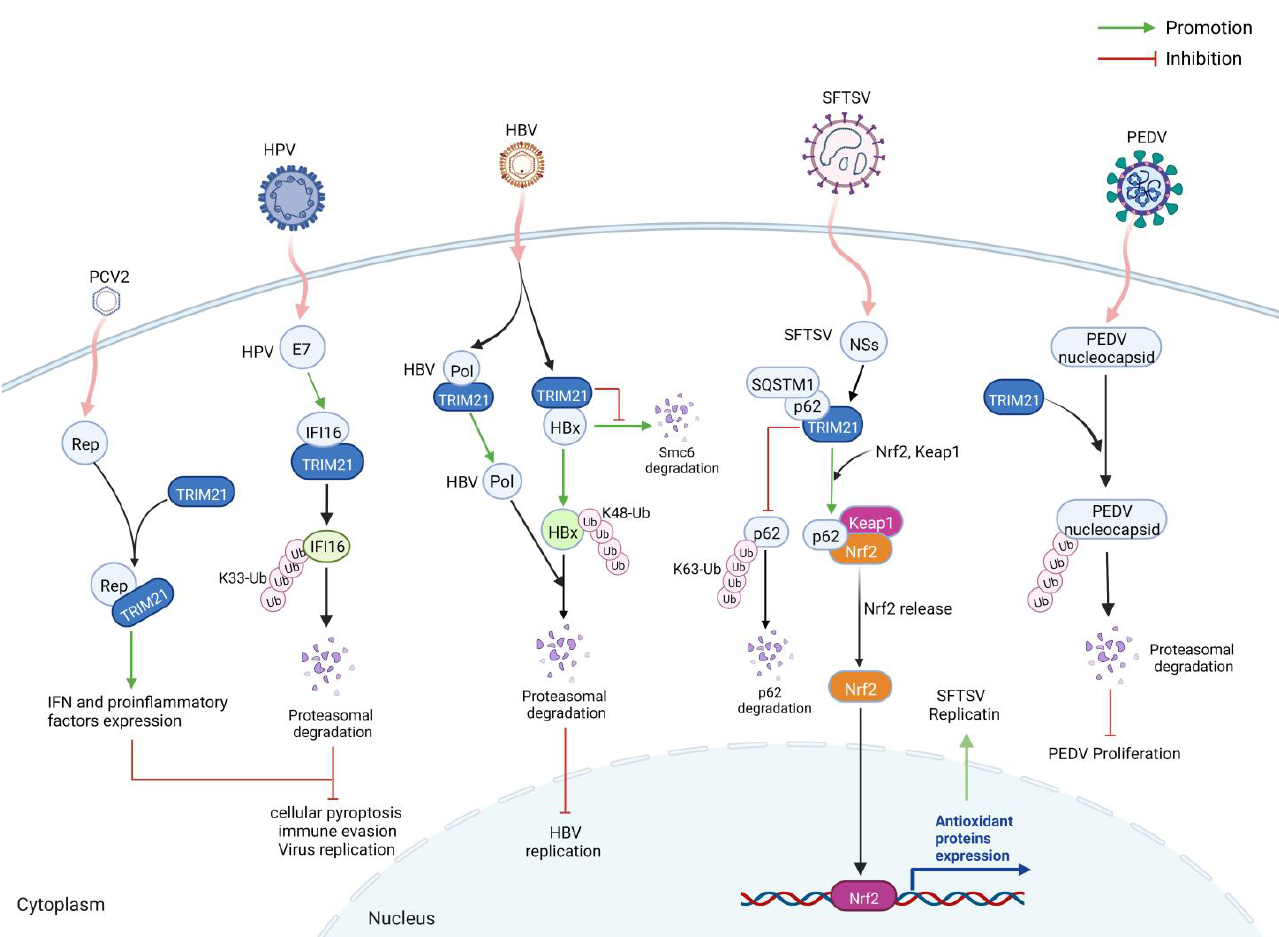
Figure 5. TRIM21 affects virus infection and immune responses by direct interacting with viral or other host proteins via its PRY/SPRY domain. Therefore, viral protein or host immune molecules are ubiquitinated by the RING domain of TRIM21 and then degraded by the proteasome, thus inhibiting virus infection. On the contrary, SFTSV can disturb the interaction between TRIM21 and p62, enhancing antioxidant responses and the p62-Keap1-Nrf2 pathway for SFTSV replication. Figure created with BioRender.com.